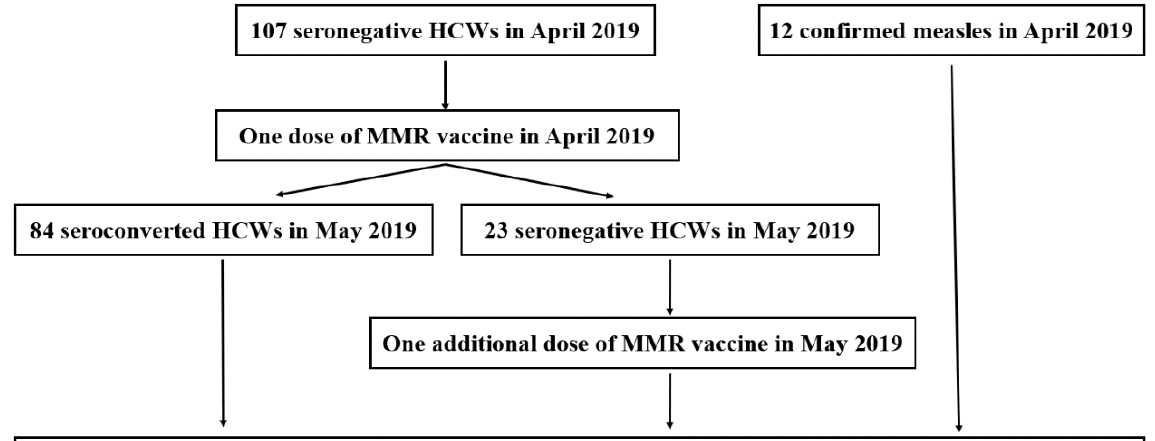
Figure 1. Study flow diagram.